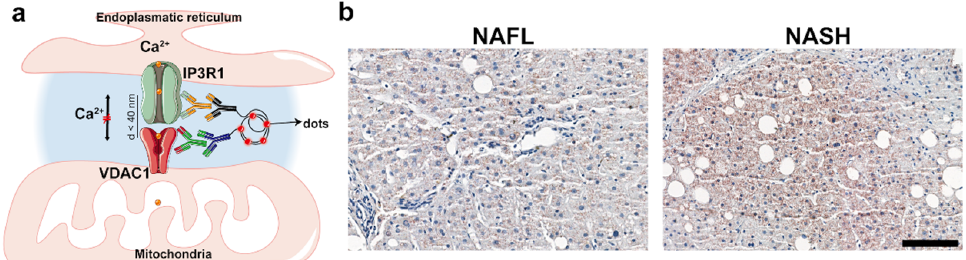
Figure 1. Schematic diagram of the PLA and representative images from NAFL and NASH liver biopsies. ( a ) Schematic diagram of the PLA; ( b ) representative images taken from 3dhistech caseviewer under 20× magnification (scale bars: 100 μ m).